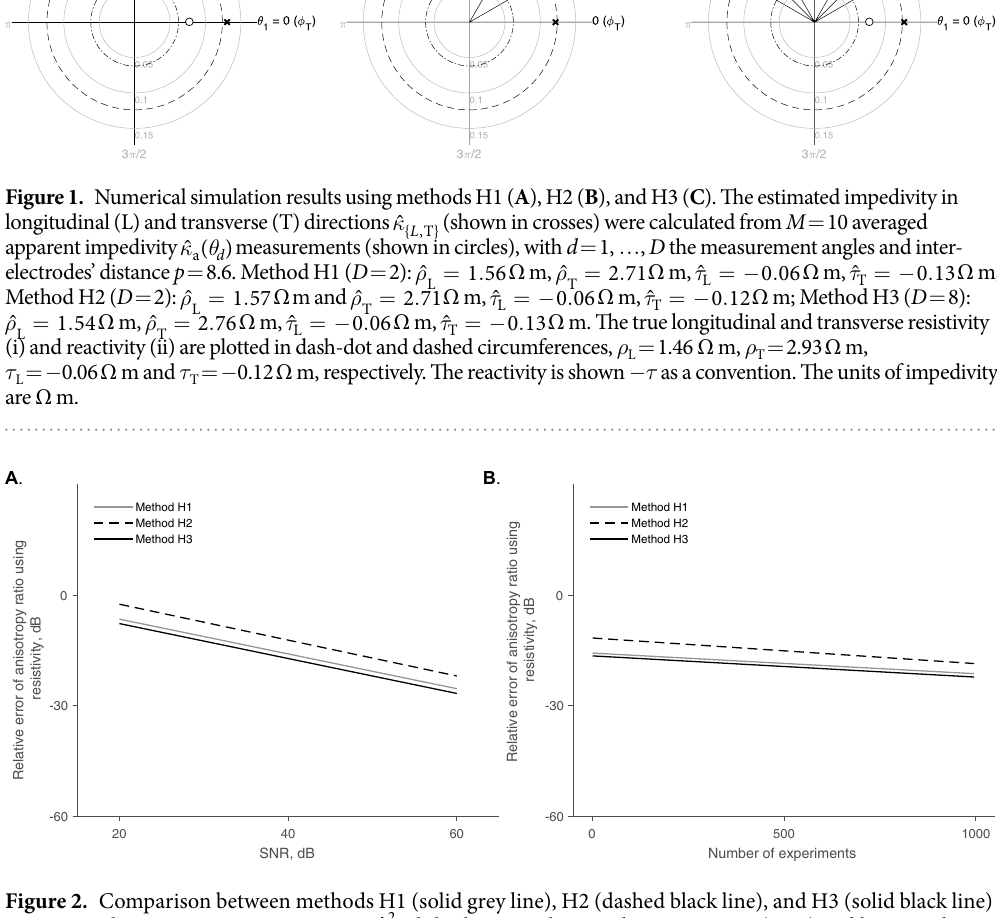
Figure 2. Comparison between methods H1 (solid grey line), H2 (dashed black line), and H3 (solid black line) estimating the resistivity anisotropy ratio α ˆ 2 while changing the signal-to-noise ratio (SNR) and keeping the number of measurements constant at M = 10 ( A ); and then while changing the number of measurements performed and keeping constant the SNR = 40 dB ( B ). Rates of decline of the relative error values between the estimated ˆ α 2 and true α 2 resistivity anisotropy ratio value are graphically shown, calculated with a linear